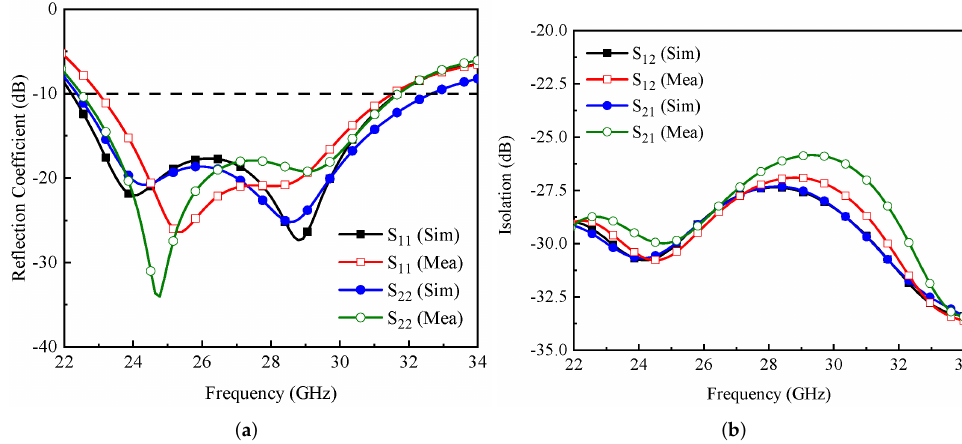
Figure 6. Simulated and measured ( a ) reflection coefficients and ( b ) port isolations of the proposed MIMO